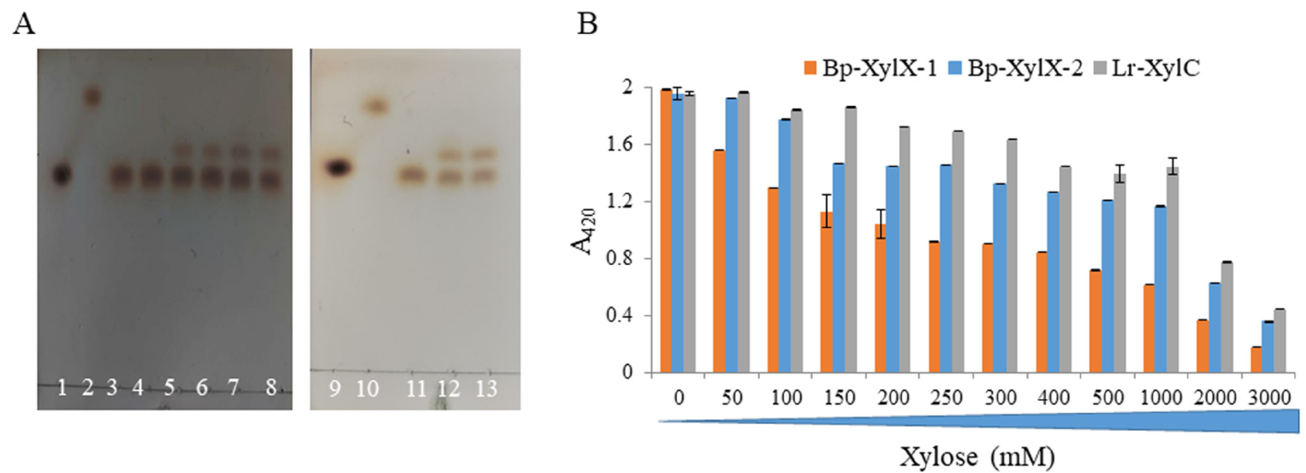
Transxylosylation activities of β -D-xylosidases were previously reported for enzymes from Bacillus halodurans [41], Aspergillus sp. [42,43], and T. saccharolyticum JW/SL-YS485 [44]. Here, we showed that Bp-XylX-1, Bp-XylX-2, and Lr-XylC released xylose from p NP-xylose as shown by TLC (Figure 4A), and showed transxylosylation activities when ethanol and methanol were used as donors. The transfer of xylose released from p NP-xylose to ethanol or methanol resulted in the formation of alkyl alcohols as confirmed by TLC (Figure 4A). The formation of ethoxylated (A) and methoxylated (B) xyloses was further confirmed by ESI-MS, showing the presence of 201 m/z (M + Na + ) and 187 m/z (M + Na + ), respectively (Figure S6).